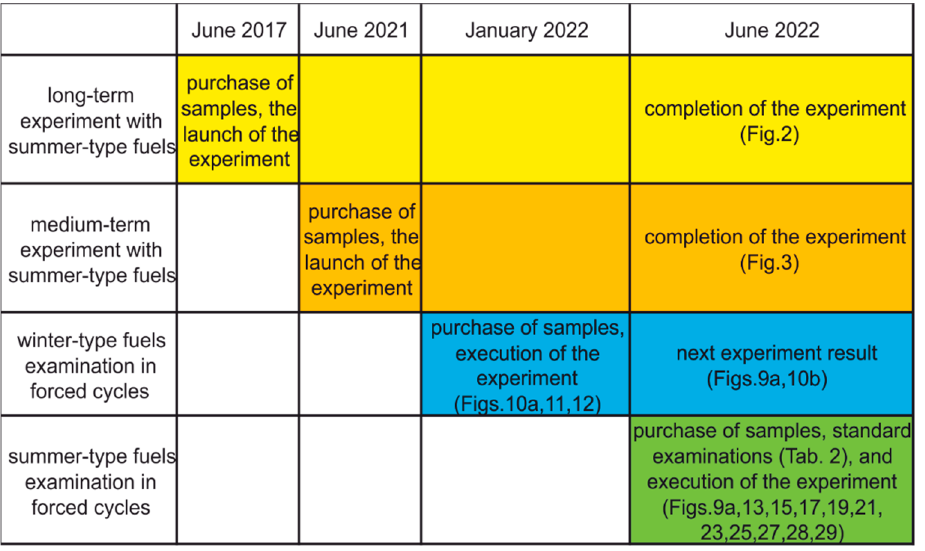
Figure 1. Gantt simplified chart of fuels examinations.